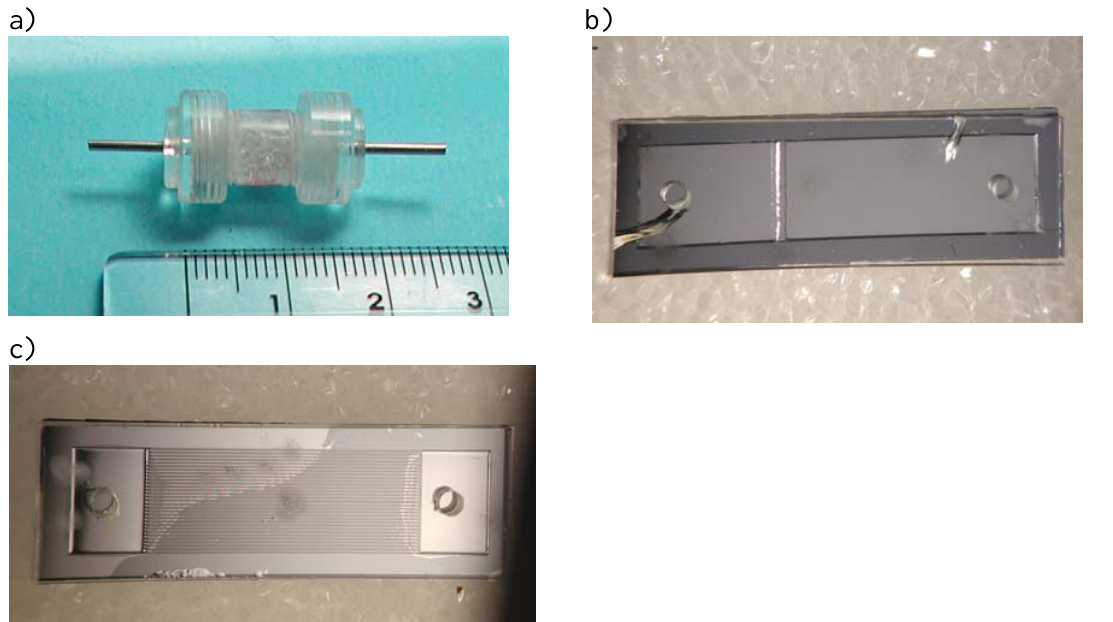
Figure 1. Microreactors: the batch type made in Perspex (a), the batch type made in silicon (b) and the lamella type made in silicon